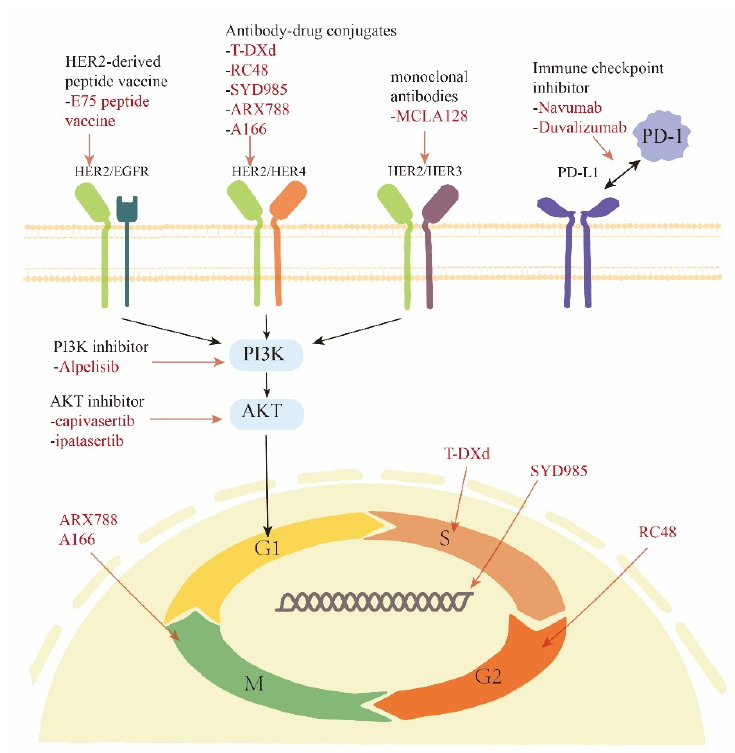
Figure 1. HER2-related therapies for HER2-low breast cancer.